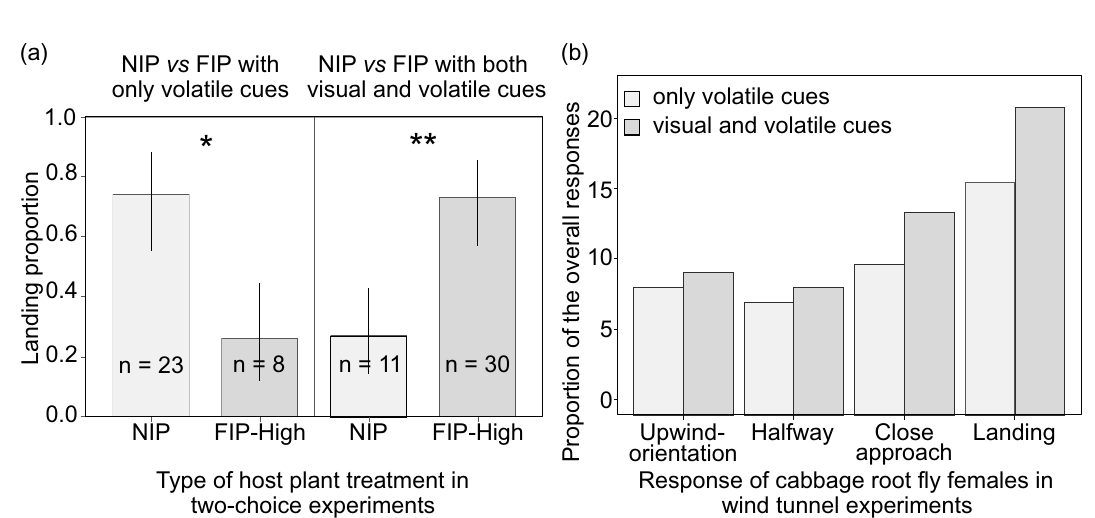
Figure 4. ( a ) Percentage (± coefficient interval) of wind tunnel landings of cabbage root fly females offered non-inoculated control plants (NIP) and root-associated entomopathogenic fungal (R-AEF)-inoculated plants at high concentration of fungal inoculum (FIP-High) in a two-choice wind tunnel experiment encountering only volatile cues and with both visual and volatile cues of host plants . Stars represent *p < 0.05, **p < 0.01, ***p < 0.001, N.S. not significant. ( b ) Bar plot of the proportion of the overall cabbage root fly females’ responses in a two-choice wind tunnel experiment with only volatile and both volatile and visual stimuli of host